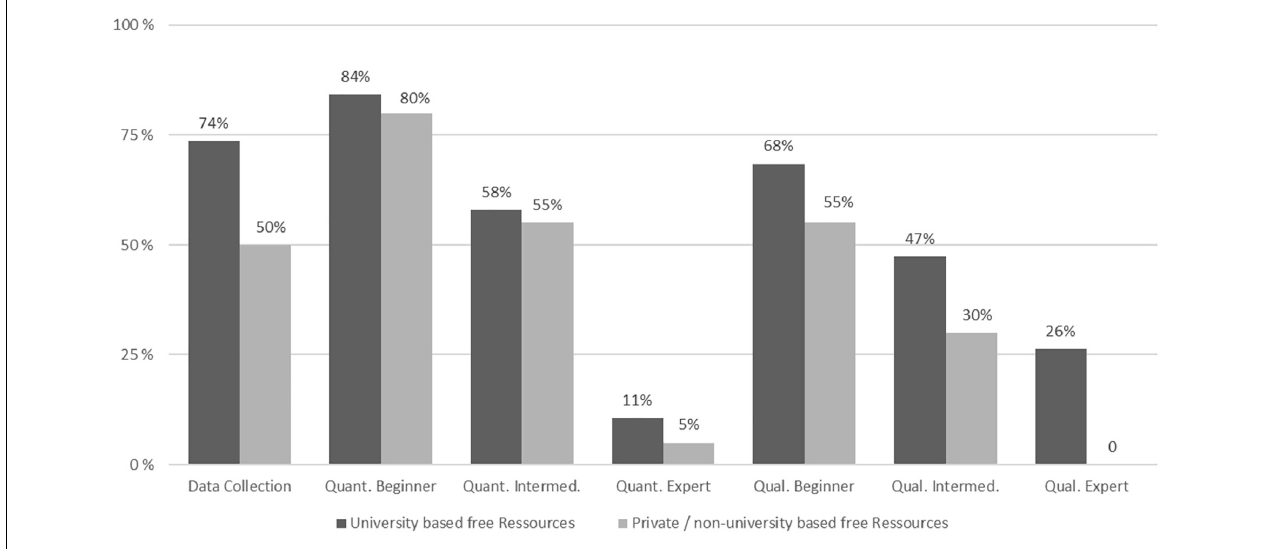
FIGURE 1 | Distribution of topics regarding free German-language social science methods resources (quasi-OER) ( n university = 19, n private =